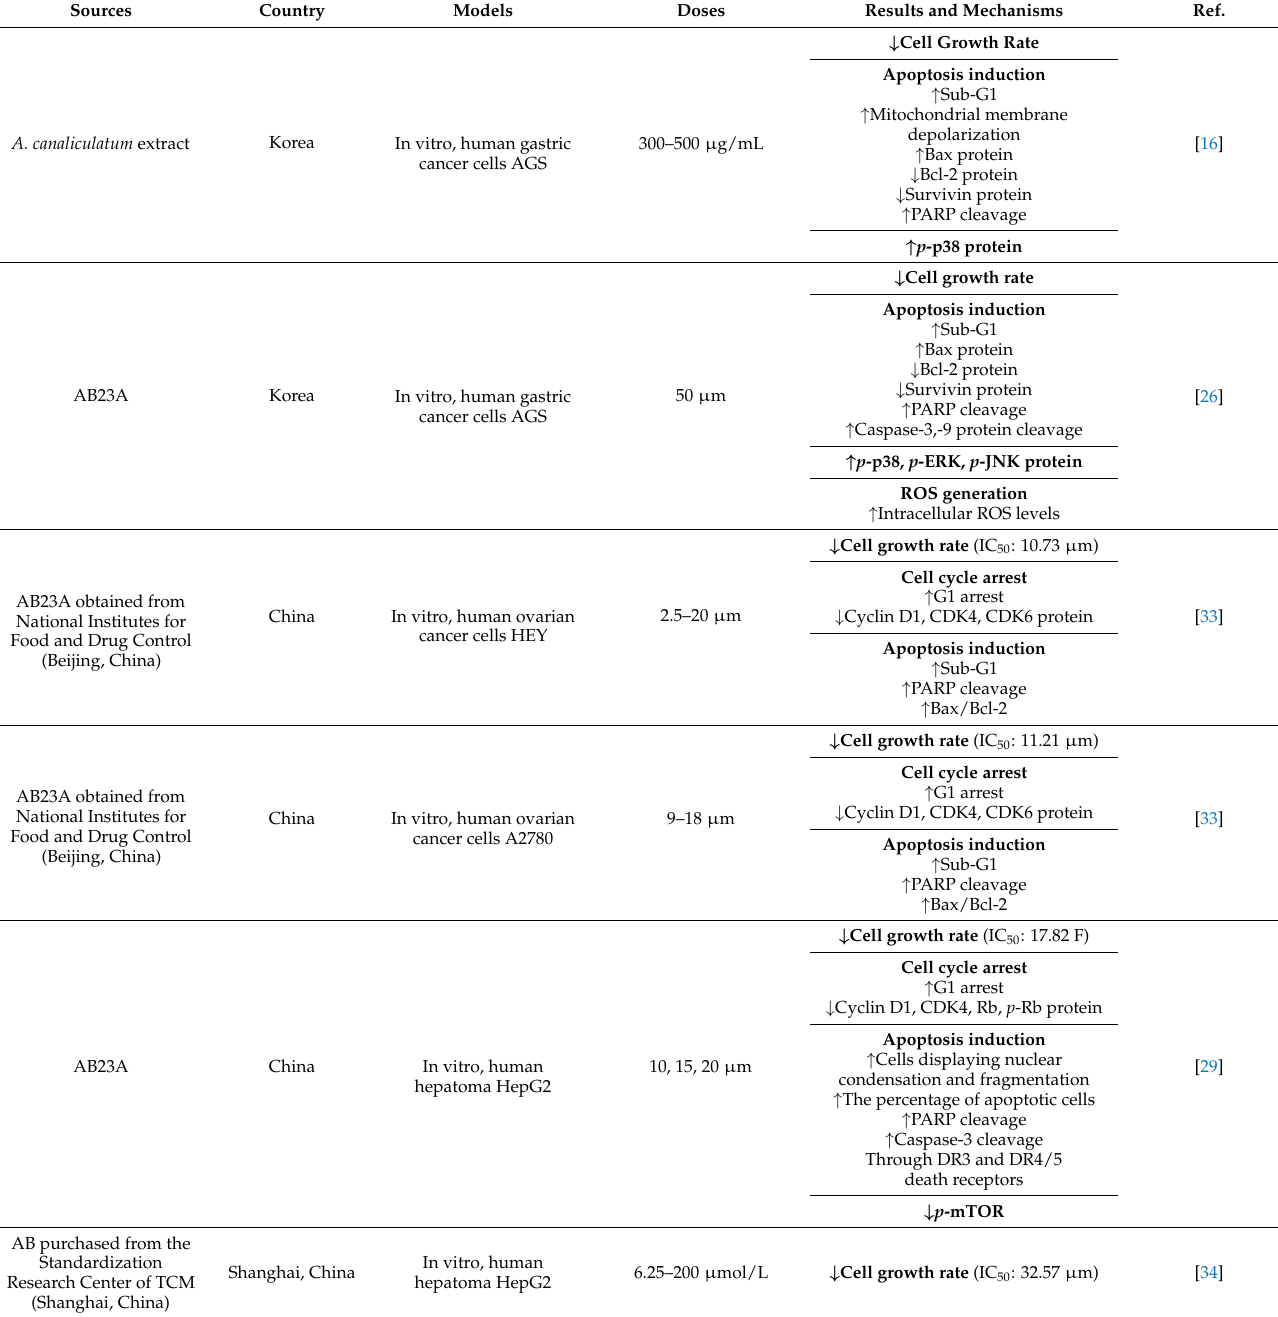
Table 1. Antiproliferative effects and molecular mechanisms of AR and its